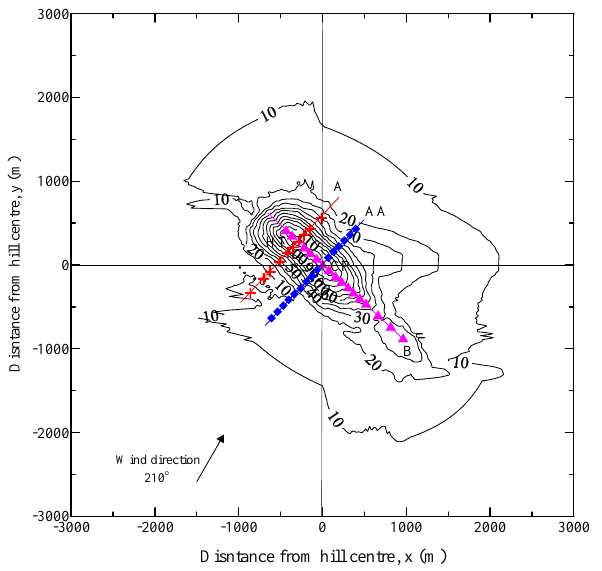
Figure 3. Computational domain of the Askervein hill and measurements tower along the A-line, AA-line and B-line. tively and are perpendicular to the ridge, and Line-B goes through HT and CP along the hill ridge. Our computational grid consists of 129 × 129 points uni- formly distributed over an area of 6000 × 6000 m 2 . This makes the resolution 46.875 m and the domain su ffi ciently large to avoid upstream e ff ects due to the periodic boundary conditions. The model run is for the wind direction of 210 ◦ , − 13 ◦ from the 223 ◦ orientation of lines A and AA. The sur- face roughness is assumed uniform and taken as z 0 = 0 . 03